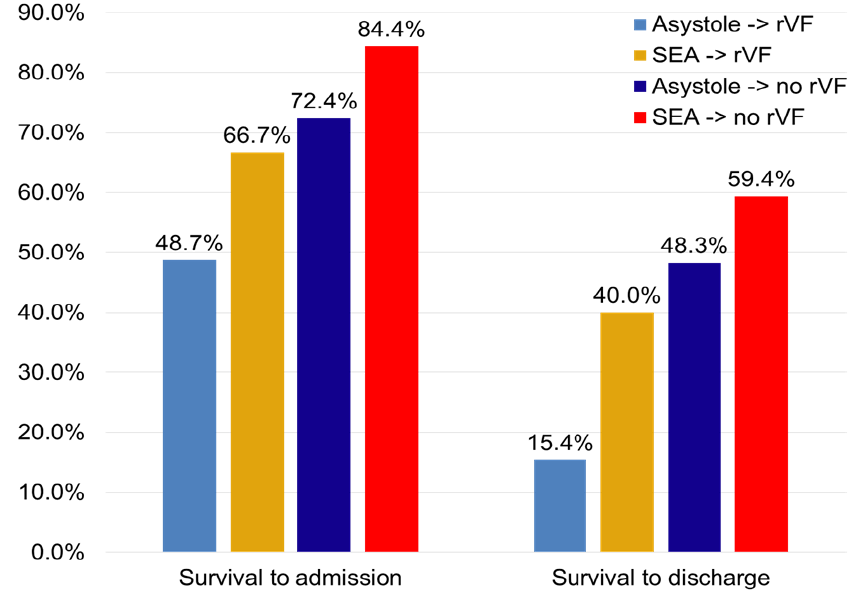
Figure 3. Short-term survival according to post-shock rhythm and rVF. rVF: recurrent VF; SEA: spontaneous electrical activity.